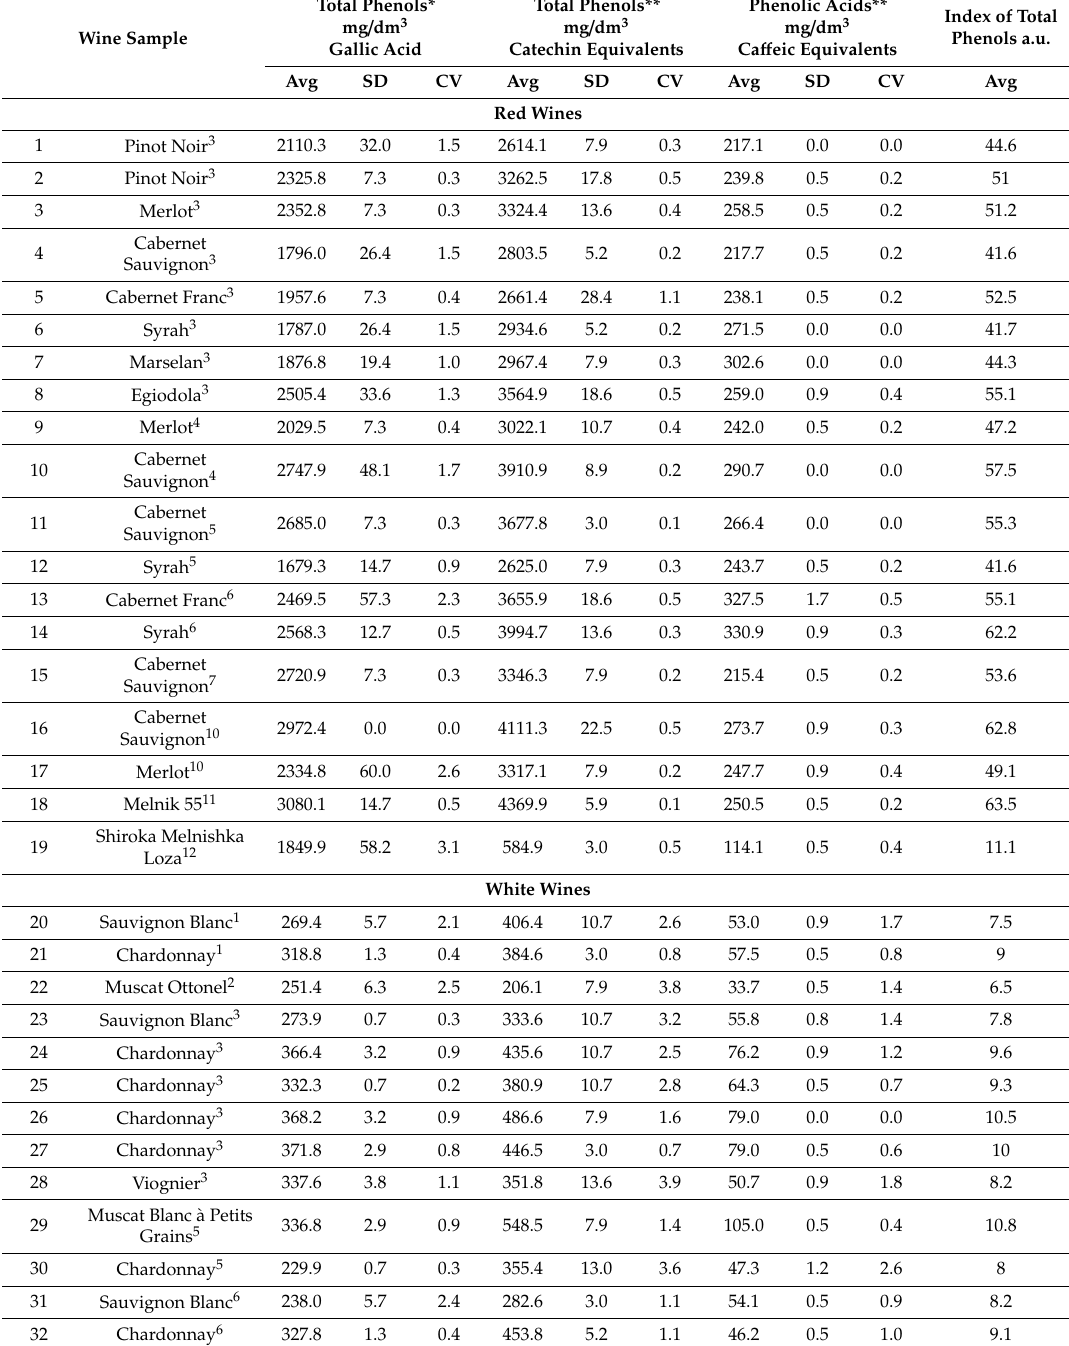
Table 1. Anthocyanin content, total and flavonoid compounds measured in the set of red and white wine